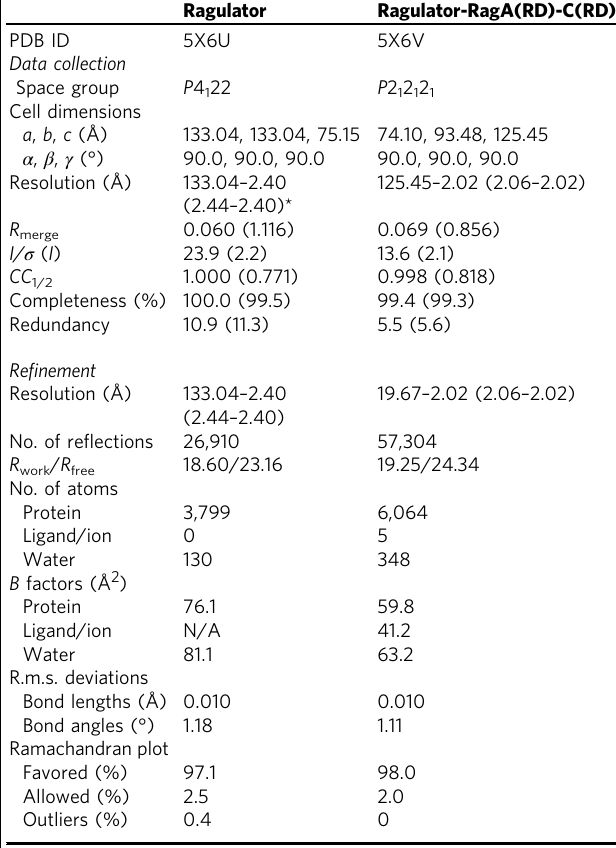
Table 1 Data collection and re fi nement statistics